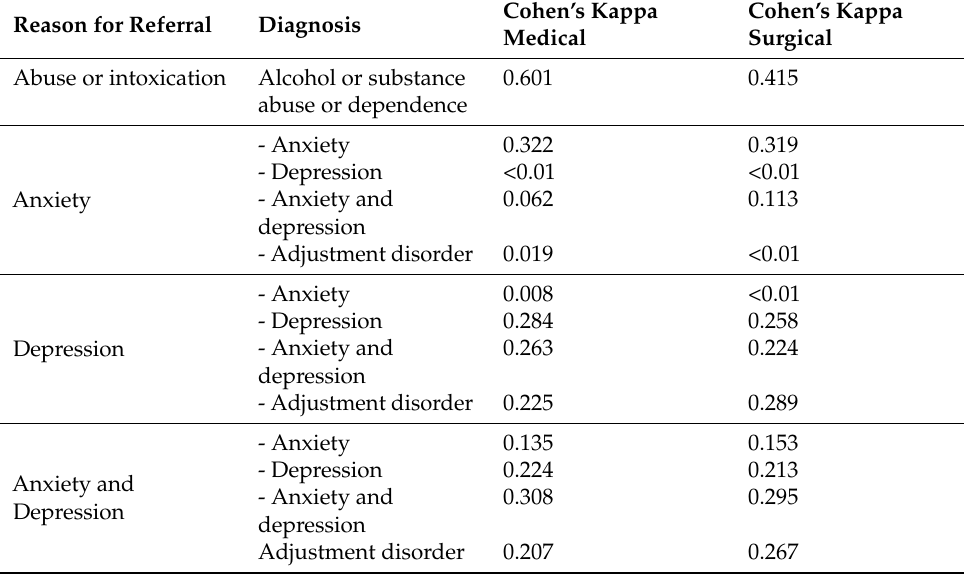
Table 3. Comparison of inter-rater agreement: Referrals from medical wards vs. surgical